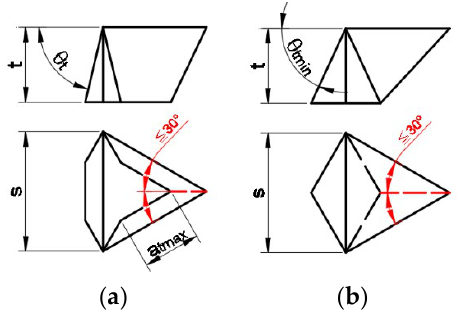
Figure 13. Dimensional restrictions in triangular components inspired by Frezier blocks.